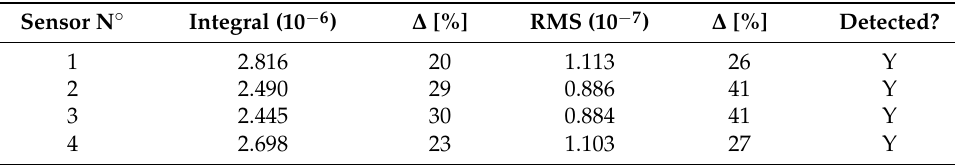
Table 7. Integral and RMS of frequency spectrum, edge below impactor. Sensor N